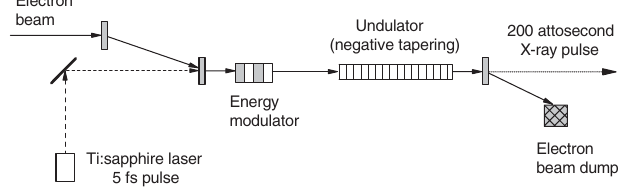
FIG. 4. Schematic diagram of the attosecond x-ray source. The energy modulator performs slice energy modulation of the electron bunch (see Fig. 6). The undulator tapering leads to FIG. 3. Normalized power versus undulator length. Solid line complete suppression of the amplification process in the largest (cid:3) 0 ; triangles: ^ (cid:4) (cid:3) 4 , ^ b (cid:3) (cid:5) 2 ; solid line 2: ^ (cid:4) (cid:3) 1: ^ (cid:4) (cid:3) 0 , ^ b fraction of the electron bunch, and the output x-ray pulse has 200 1 1 (cid:3) 0 ; circles: ^ (cid:4) (cid:3) 0 , ^ b (cid:3) 2 . attosecond pulse 4 , ^ b 1 1